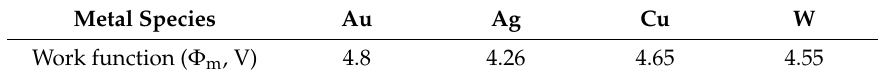
Table 2. Work functions (Φ m ) for several useful metals.